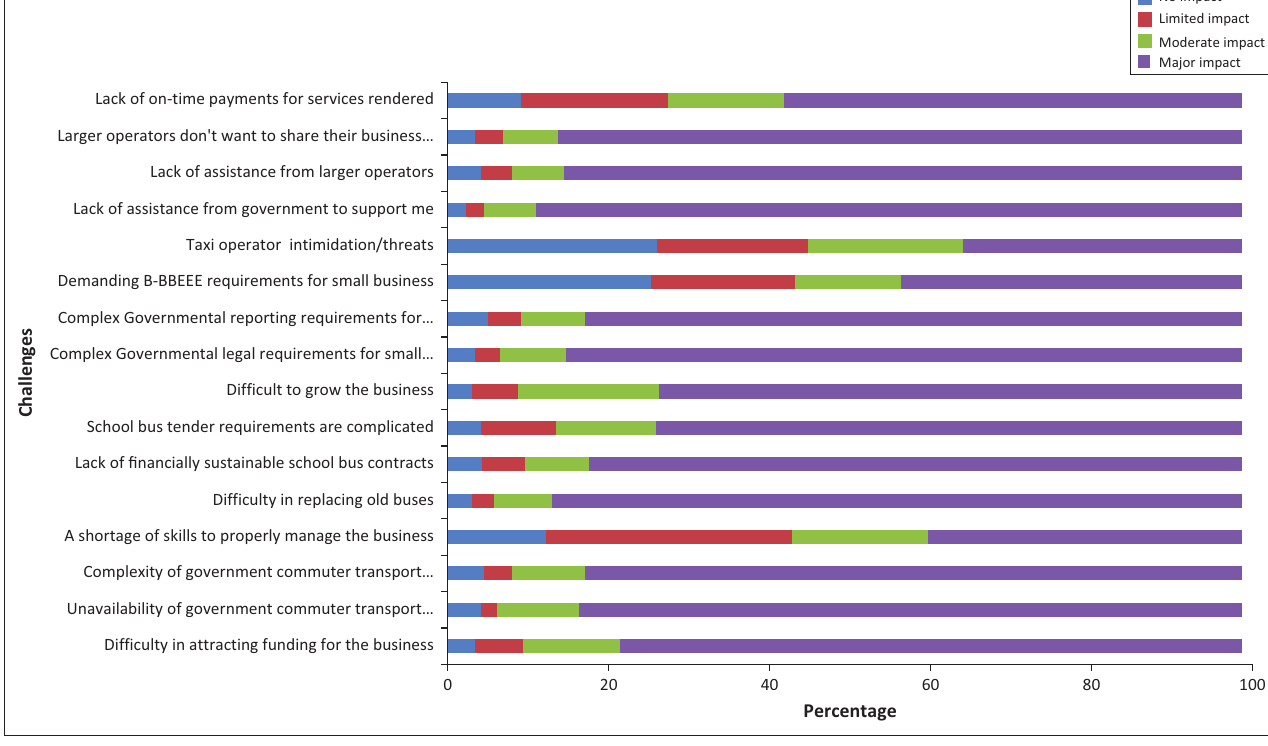
FIGURE 4: Importance of challenges facing small-bus operators. TABLE 2: Factor loadings after rotation: Challenges facing small-bus